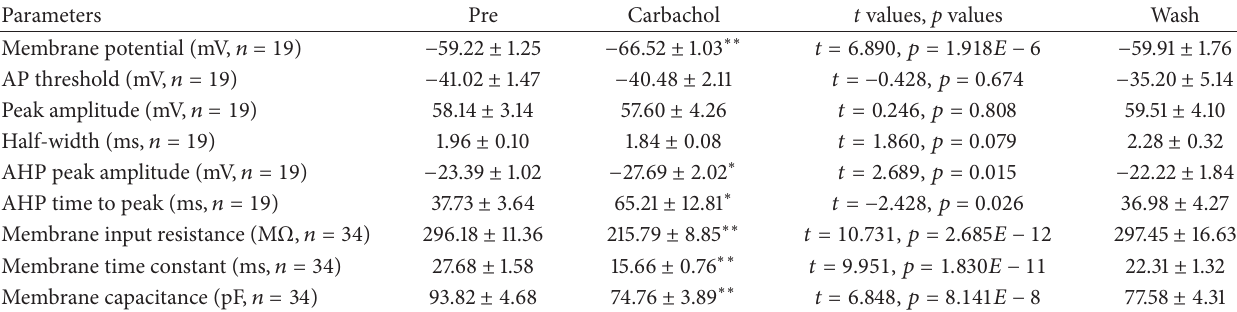
Table 1: Measurements of intrinsic properties of RA projection neurons before and during 30 𝜇 M carbachol application, as well as after carbachol washout.